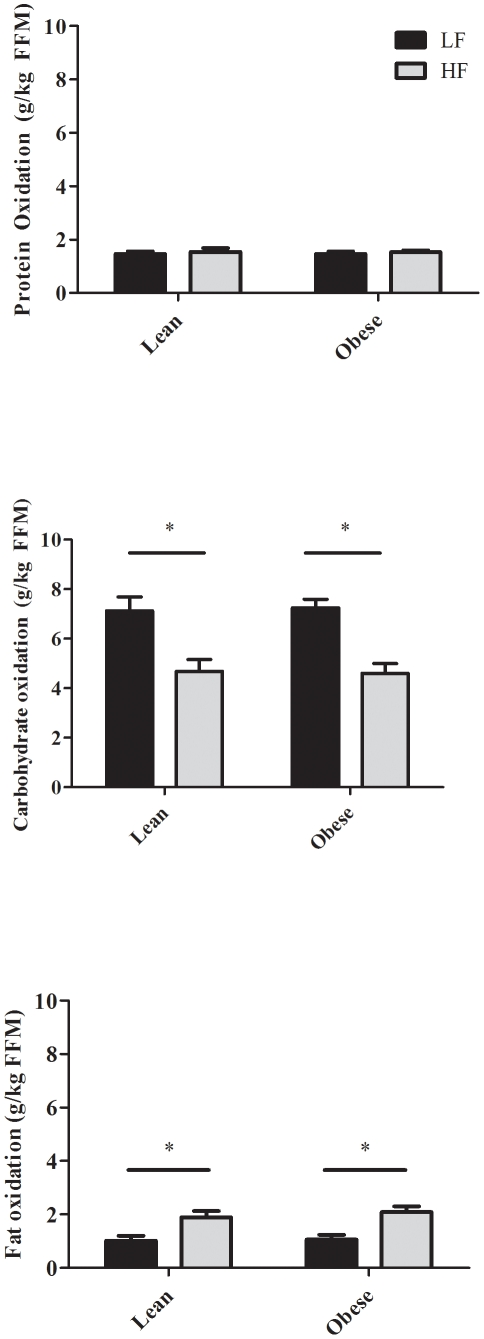
Mean (± SE) Protein (Top), carbohydrate (Middle), and fat (Bottom) oxidation (g/kg FFM/day) measured using room calorimetry during LF (black bars) and HF (grey bars) in LN (N = 10) and OB (N = 9).* LF significantly different from HF (P<0.05).